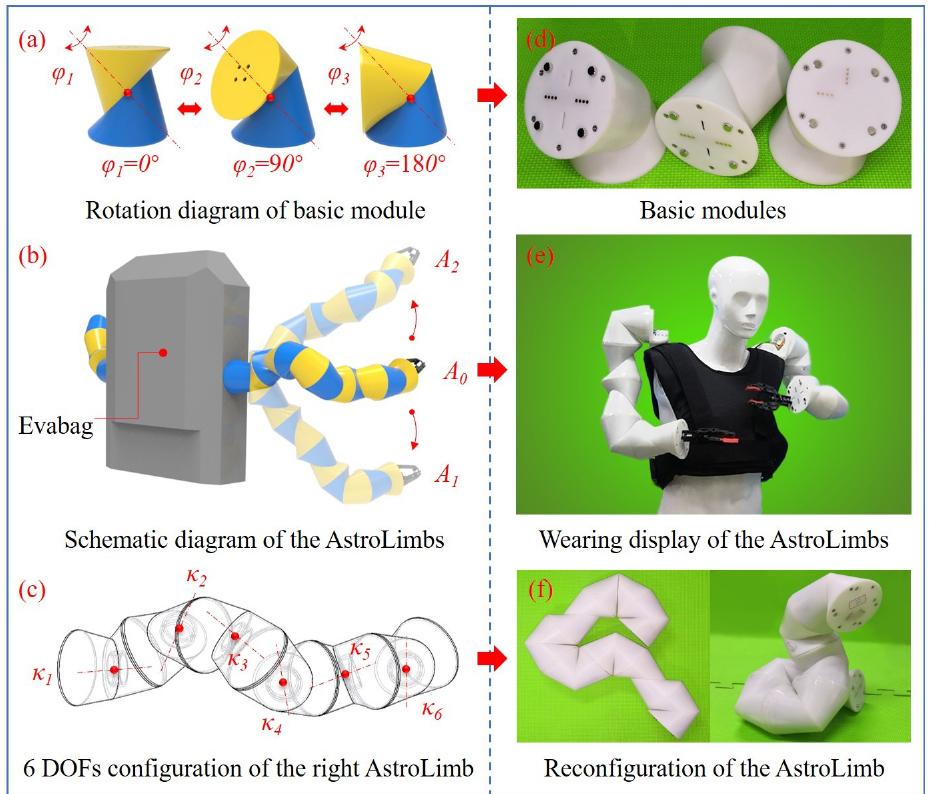
Figure 2. Wearable robotic limbs for astronaut extravehicular activities assistance. ( a ) Rotation diagram of basic module. ( b ) Schematic diagram of the AstroLimbs. ( c ) 6 DOFs configuration of the right AstroLimb. ( d ) Basic modules. ( e ) Wearing display of the AstroLimbs. ( f ) Reconfiguration of the